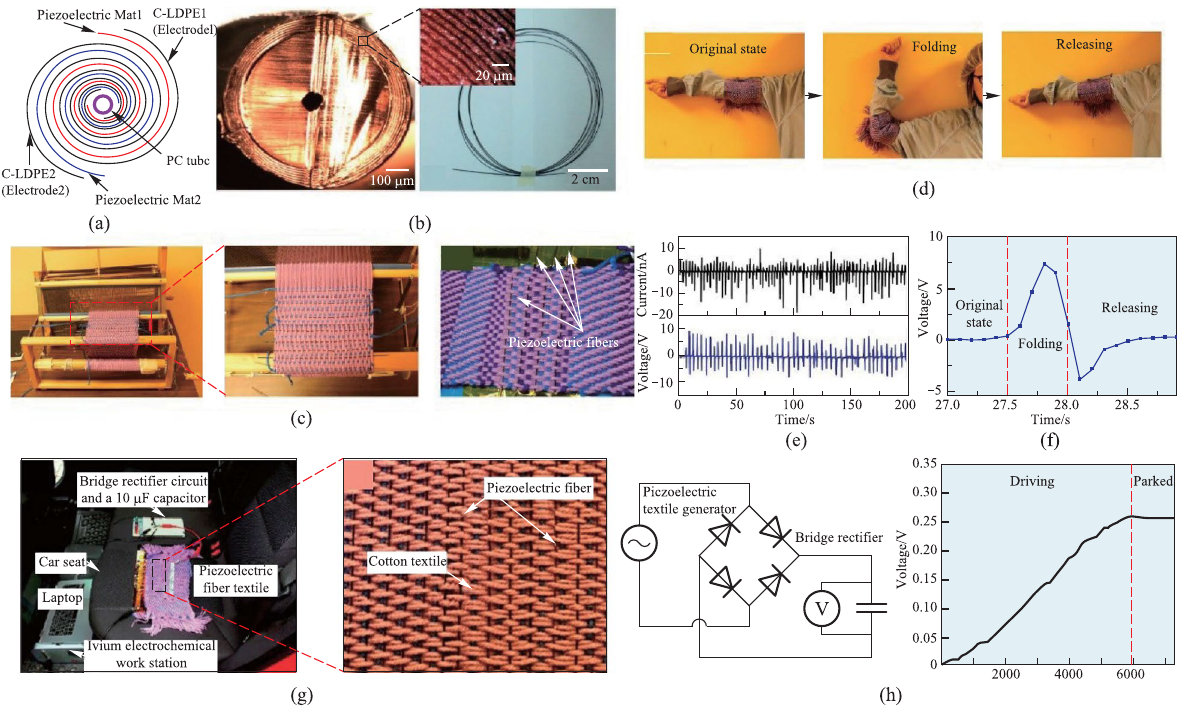
Fig. 10 TDPF energy harvesters. a Structure of a spiral TDPF for energy harvesting. b Photo of the cross-section of the TDPF. c TDPFs were woven into textiles forming piezoelectric energy harvesting systems via the Dobby loom process. d A TDPF textile used as a prototype genera- tor with a 90° folding–release action of the elbow. e Open-circuit voltages and short-circuit currents generated by the piezoelectric textile during repeated fold–release motion of the elbow. f Open-circuit voltage of the piezoelectric textile in a fold–release elbow action. g Experimental setup of an in-car test for the TDPF textile used as an automotive microgenerator pad. h Energy generation performance of the TDPF seat pad genera- tor during a 6000 s driving test charging a 10 μF capacitor. Reprinted with permission from Ref.